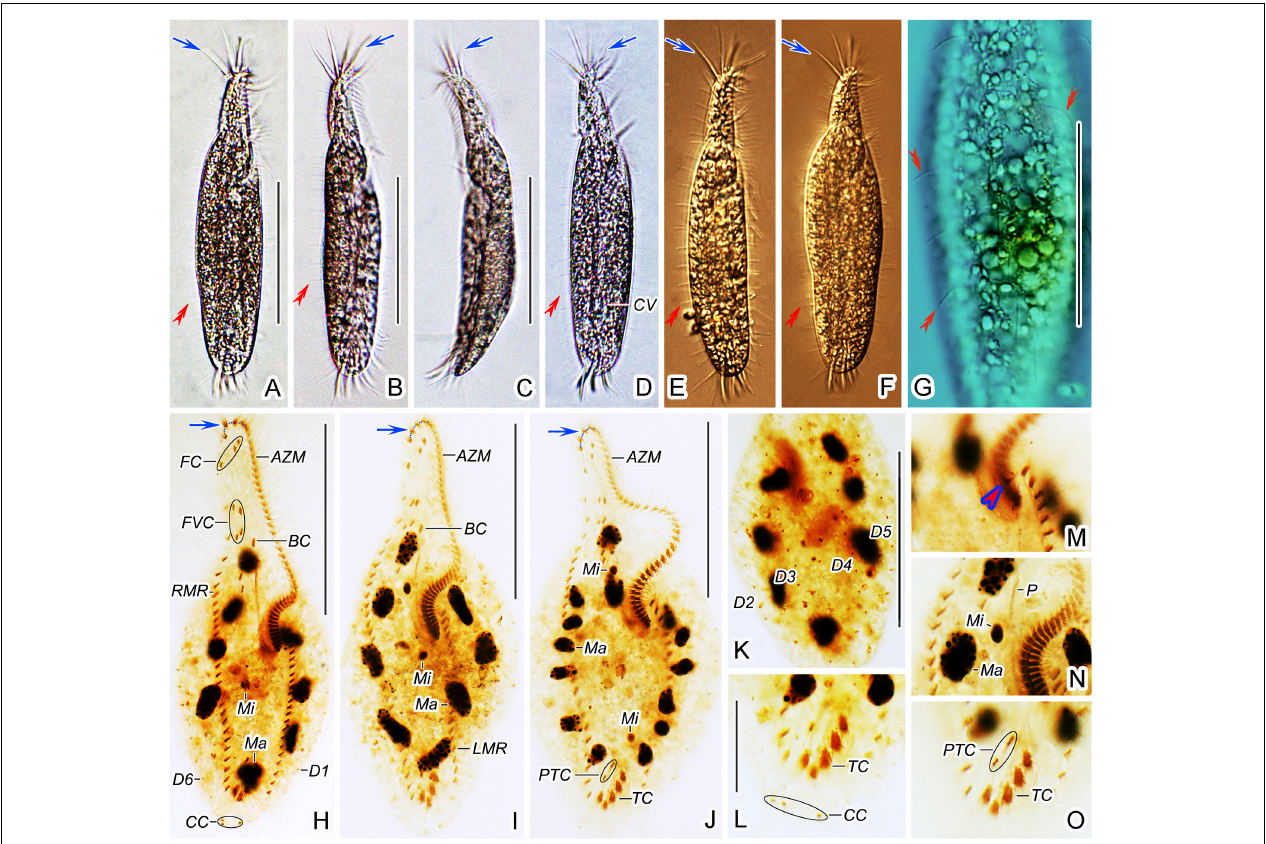
FIGURE 7 | Trachelostyla pediculiformis pop. 1 from life (A–G) and after protargol impregnation (H–O) . (A–F) Ventral (A,B,D–F) and lateral (C) overviews of different individuals, showing the body shape and dorsal bristles (red double-arrowheads). Blue arrows show enlarged adoral membranelles. (G) Dorsal view, showing endoplasmic granules and dorsal bristle (red double-arrowheads). (H–J) Ventral views of different specimens, showing the ciliary pattern and the nuclear apparatus. Blue arrows show enlarged adoral membranelles. (K) Dorsal view. (L,O) Detailed ventral views of the posterior body region, showing the three caudal cirri, two pretransverse ventral cirri, and five transverse cirri. (M,N) Detailed ventral view of the proximal end of the adoral zone of membranelles to show the extra cirrus right of the left marginal cirral row (red arrowhead), the macronuclear nodules and micronuclei as well as the paroral membrane. AZM, adoral zone of membranelles;